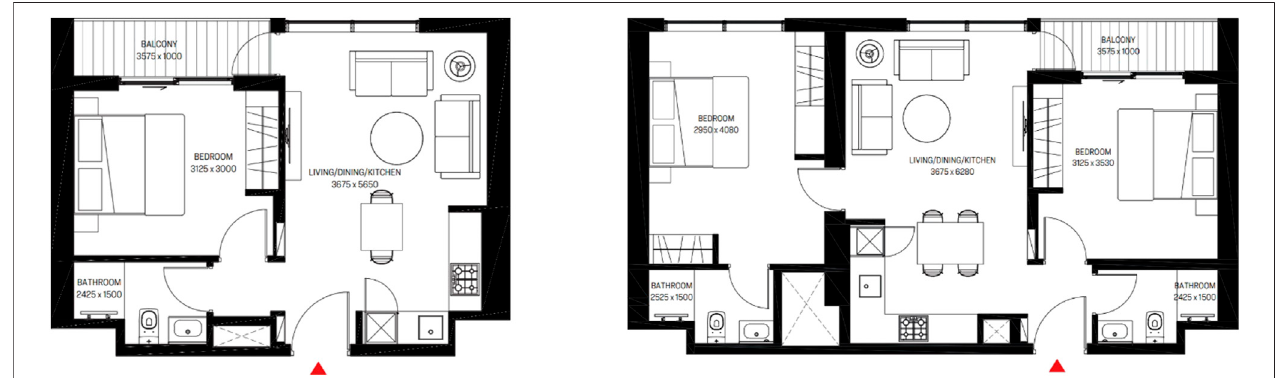
FIGURE 2 | The plan of one bedroom (A) and two bedroom (B) in SOL